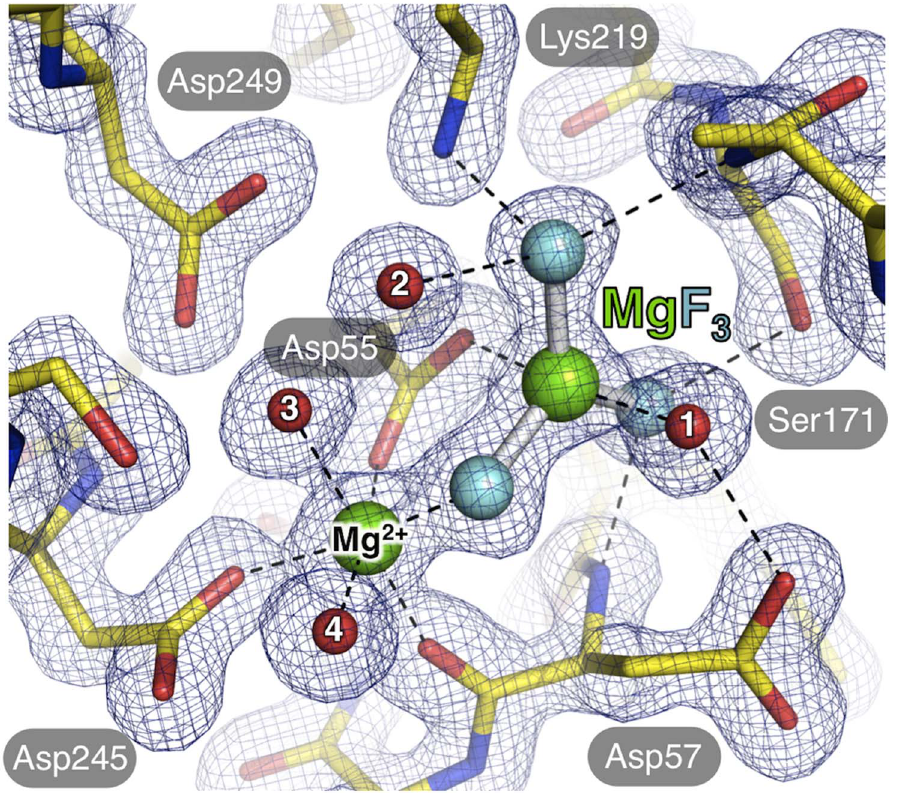
Figure 3. Organization of the catalytic center of Dm cN-IIIB. The magnesium ion (green sphere) is octahedrally coordinated by several residues of Dm cN-IIIB shown as stick model (carbon in yellow, nitrogen in blue, oxygen in red) as well as several water molecules (red). One equatorial coordination position of Mg 2 + is occupied by a fluorine atom of the co-crystallized metal fluoride MgF 3– (magnesium in green; fluorine in light blue). MgF 3– is coordinated by Asp55, Asp57, Lys219, Ser171 as well as water molecules. Note that the coordination of MgF 3– represents the pentavalent phosphate transition state in the nucleotidase reaction cycle. Contacts are represented by dashed lines and the model is defined by a representative 2 mF o – DF c electron density map (blue mesh) contoured at a sigma level of 2.0.